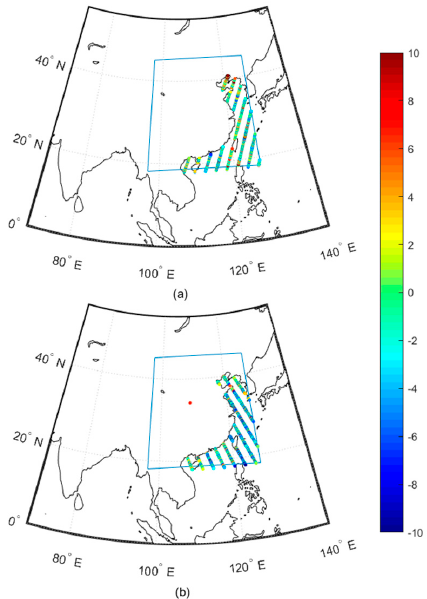
Figure 3. The di ff erence to CODE (Center for Orbit Determination in Europe) in cycle 152: ( a ) ascending Figure 3. The difference to CODE (Center for Orbit Determination in Europe) in cycle 152: ( a ) passes and ( b ) descending passes. ascending passes and ( b ) descending passes.